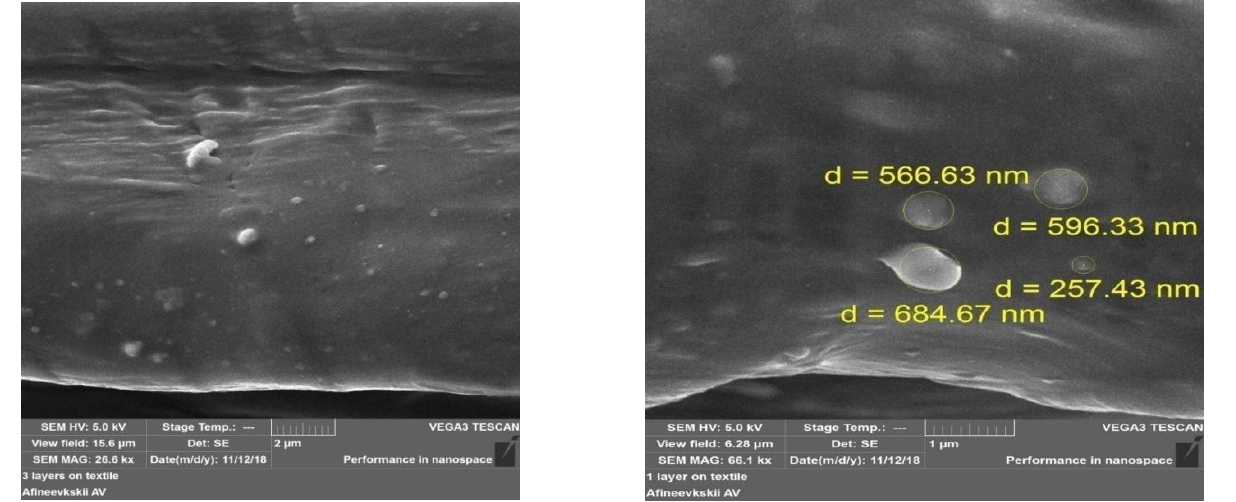
Figure 1. SEM photograph of textile material containing polyelectrolyte microcapsules.